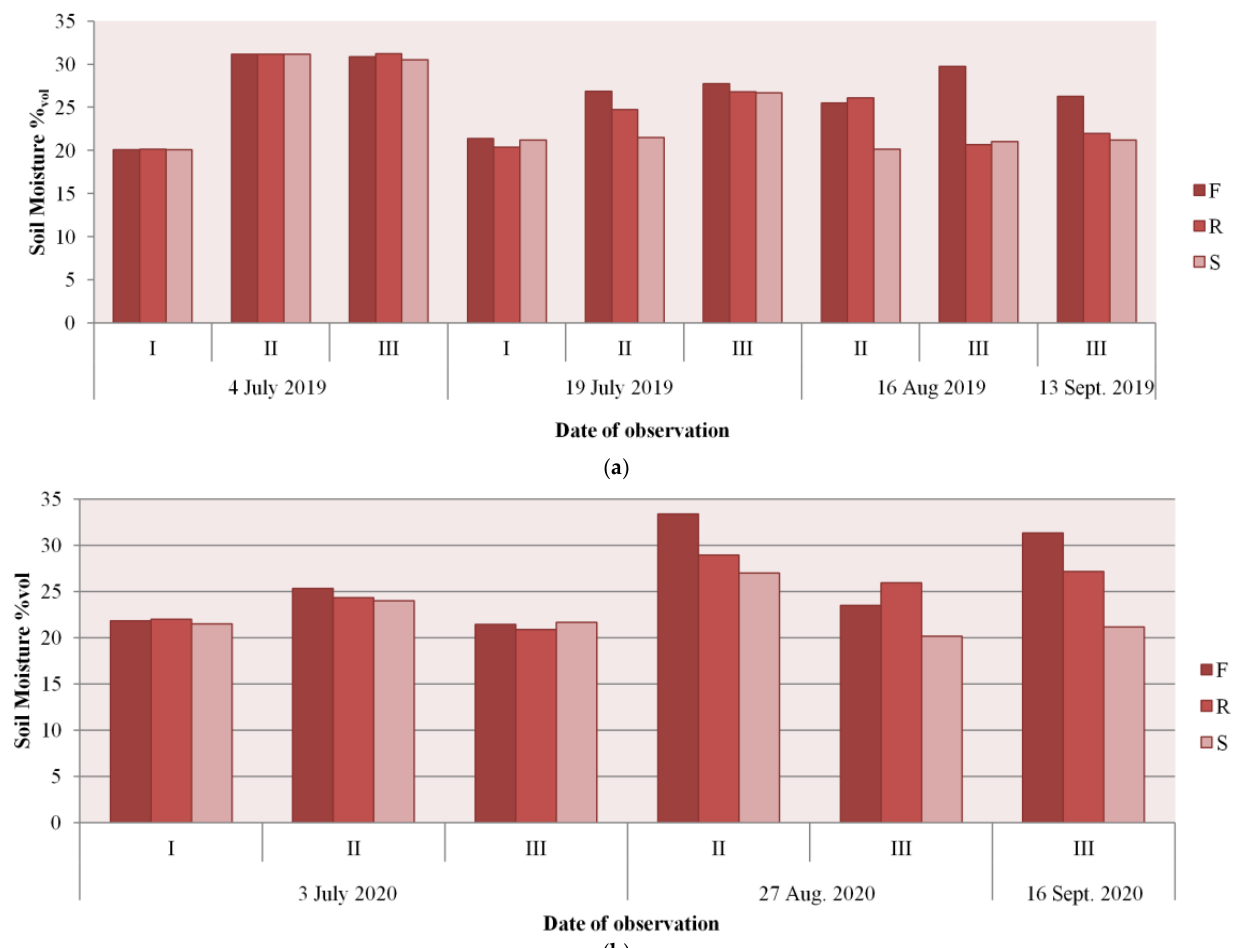
Figure 8. ( a ) Soil moisture per UAV imagery in 2019. ( b ) Soil moisture per UAV imagery in 2020 for the F, R and S treatments in three sowing periods (I, II, and III).